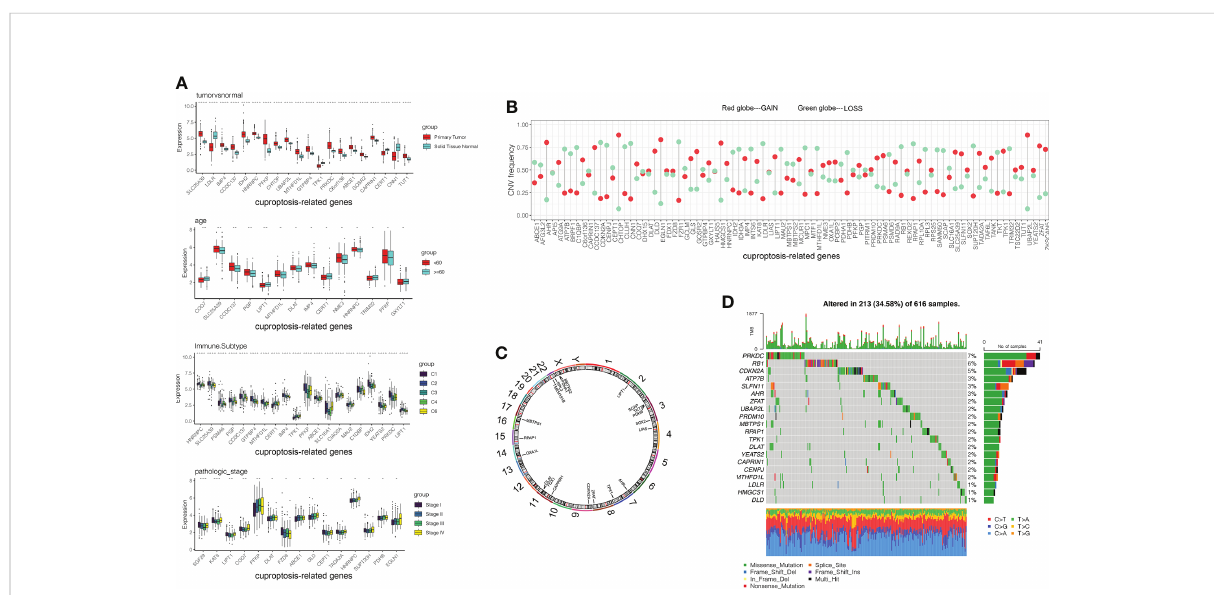
FIGURE 1 Genetic landscape and expression levels of CRGs in LUAD. (A) Expression of CRGs in clinical samples classi fi ed by tumor tissue, age, immune subtypes and pathological tumor stage. (B) Frequencies of CNV gain, loss, and non-CNV among 86 CRGs. (C) Locations of CNV alterations in CRGs on 23 chromosomes. (D) Mutation frequencies of CRGs in 507 patients with LUAD from the TCGA cohort. CGRs, cuproptosis-related genes; LUAD, lung adenocarcinoma; TCGA, The Cancer Genome Atlas; CNV, copy number